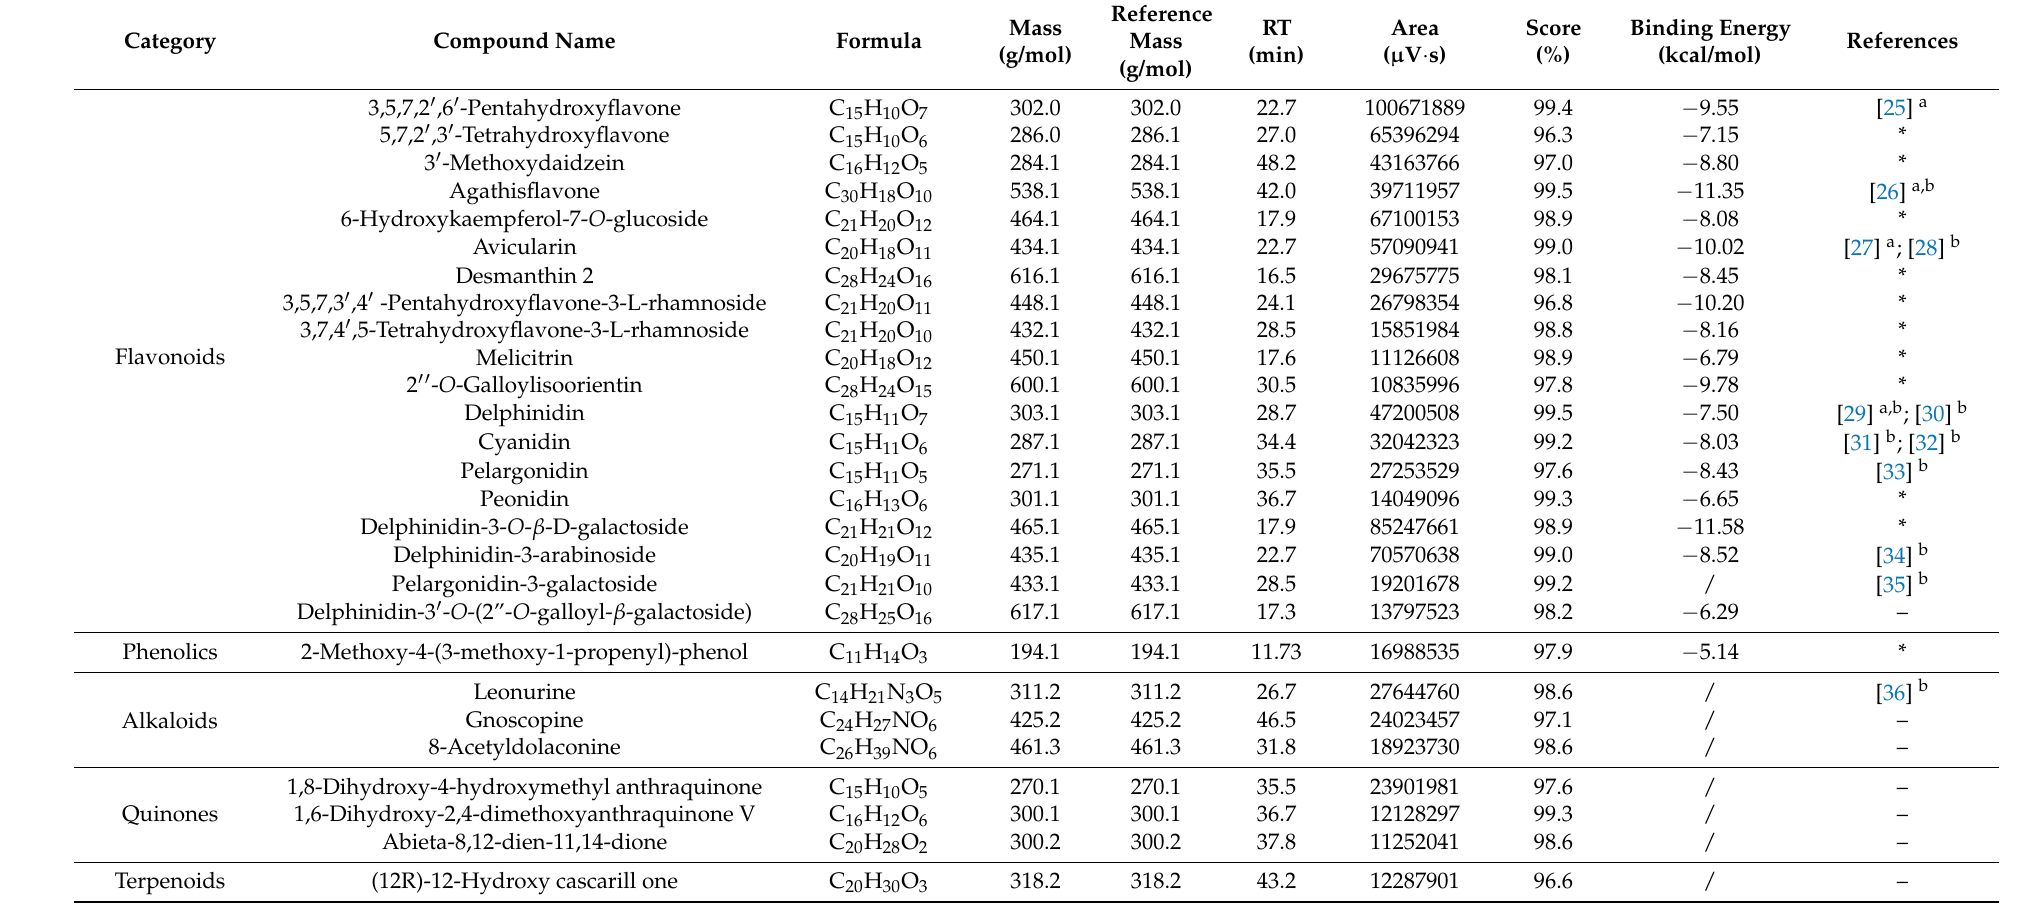
Table 2. HPLC/MS analysis and molecular docking results of compounds detected from